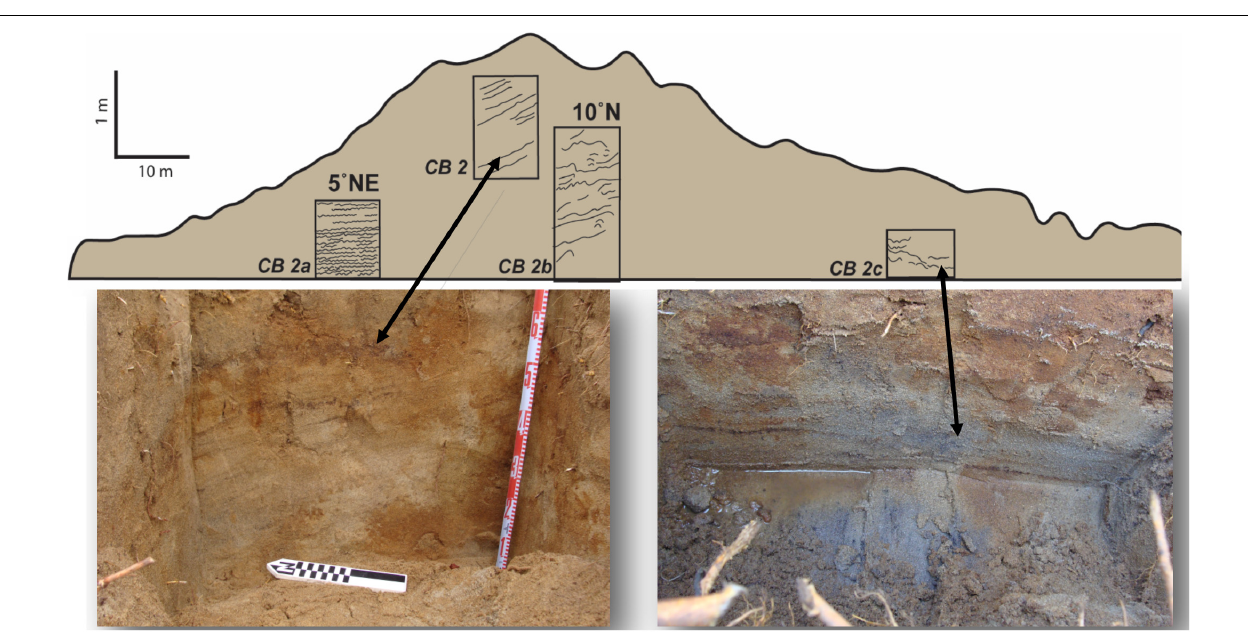
FIGURE 5 | Examples of primary planar cross-beds showing true dip angle and direction in linear dune at U.S. Route 52 road cut for Section